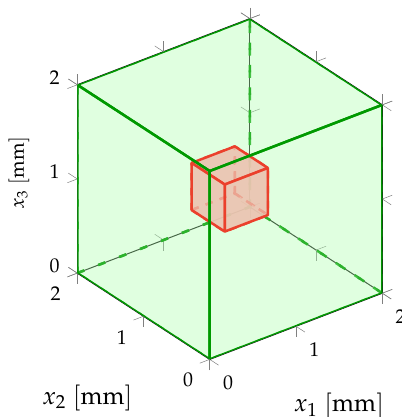
Figure 7. Illustration of the test specimen occupying the 3D cubic macroscopic domain of observation Ω macro = Ω macro (in green) which contains a 3D cubic mesoscopic domain of observation Ω meso exp Ω meso (in red) for the numerical validation in 3D linear